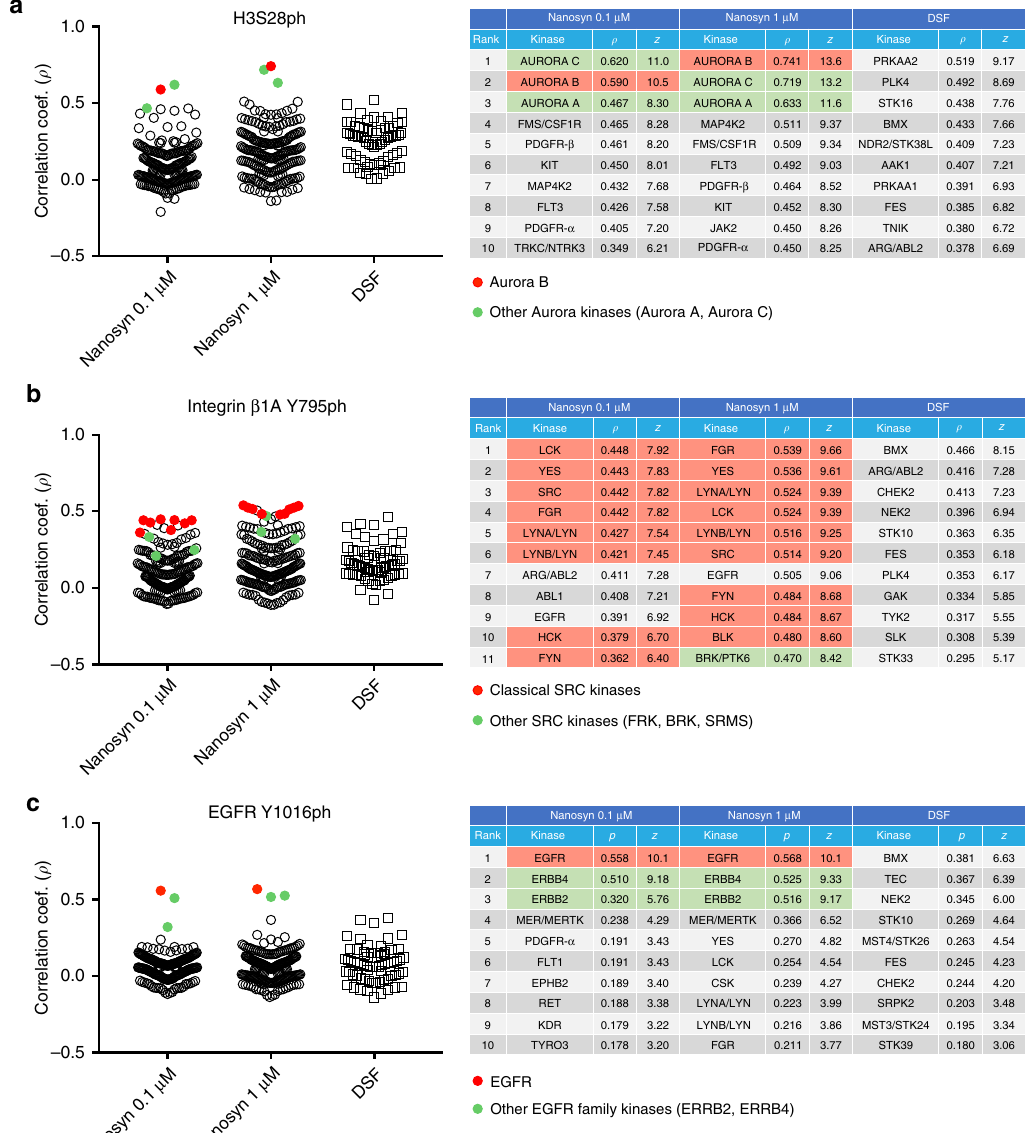
Fig. 2 Results of KiPIK screens using the PKIS1 inhibitor library. a H3S28ph, b Integrin β 1A Y795ph, and c EGFR Y1016ph. In each case, stripcharts on the left show the Pearson correlation coef fi cients between the %inhibition results from the KiPIK screen and the % inhibition results for each of the kinases in the Nanosyn pro fi ling datasets at 0.1 and 1 µ M, and the DSF pro fi ling dataset. The tables on the right show the top 10 (or 11) hits from each pro fi ling dataset with corresponding correlation coef fi cients ( ρ ) and z -scores. Expected kinase(s) are shown in red, and closely related kinases in green. Note that Aurora kinases are not present in the DSF dataset, and Src and EGFR-related kinases are not present in the Nanosyn datasets. Source data are provided as a Source Data fi